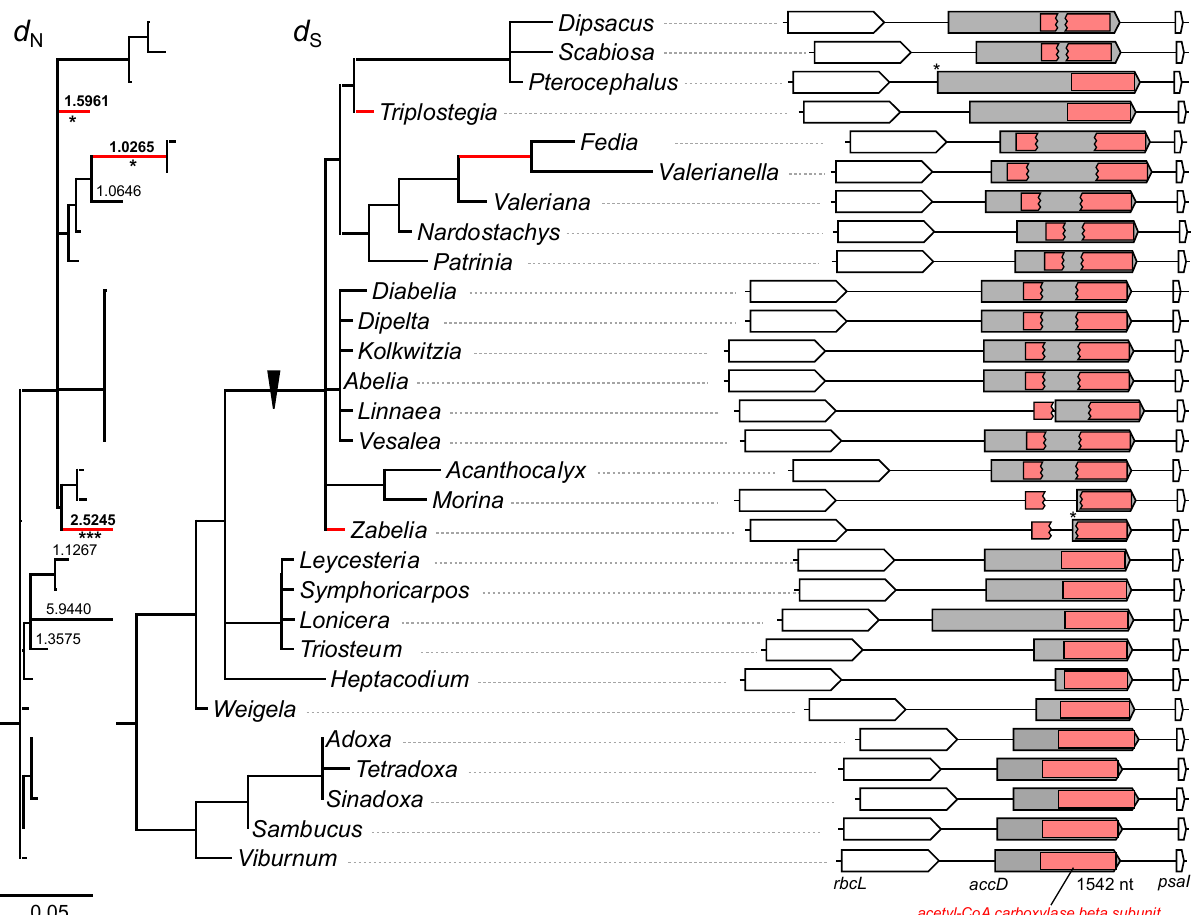
Figure 3. Rapid structural evolution of the accD gene. Phylograms show nonsynonymous ( d N ) and synonymous ( d S ) substitution rates for the accD among the analyzed Caprifoliaceae s.l. with outgroups. Scale bar indicates the number of substitutions per site. Gray boxes indicate the predicted open reading frames (ORFs). Red rectangles indicate the conserved domain in the ORFs. Asterisks indicate that the ORF has an alternative start codon. Branch lengths are drawn to the same scale based on d N and d S substitutions per site. Branches with significantly higher d N / d S ratios, as determined by likelihood ratio test are marked with asterisks (*, p < 0.05; ***, p < 0.001 after Bonferroni correction).